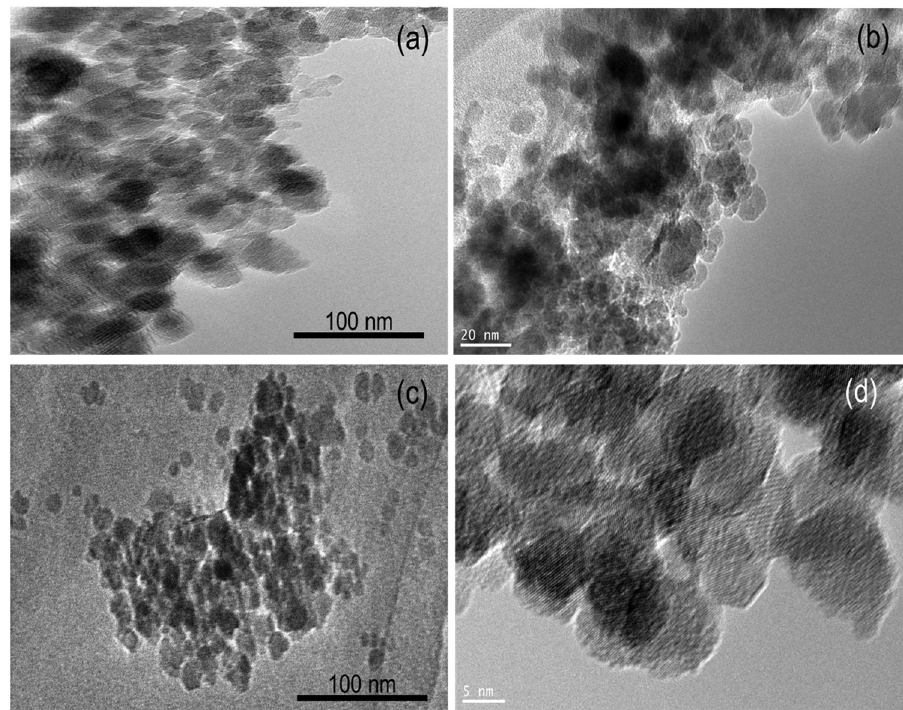
Figure 3: TEM images of ( a and b ) Fe 3 O 4 @SiO 2 and ( c and d ) Fe 3 O 4 in di ff erent magni fi